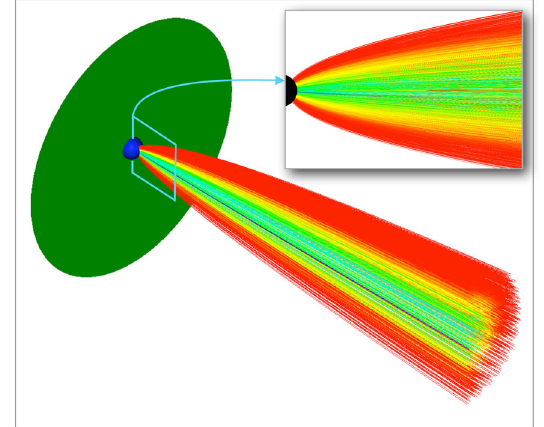
FIG. 2. Cross section of PIC simulation of field emission from hemispherical boss including space charge for 1 μ A currents. Apex field is 3 GV = m, diameter is 35 μ m. Space charge effects cause small field reductions of < 0 . 4% but have a strong impact on current ( − 7% ). Red trajectories have currents 2 orders of magnitude smaller than dark blue trajectories (visible from on-axis emission).